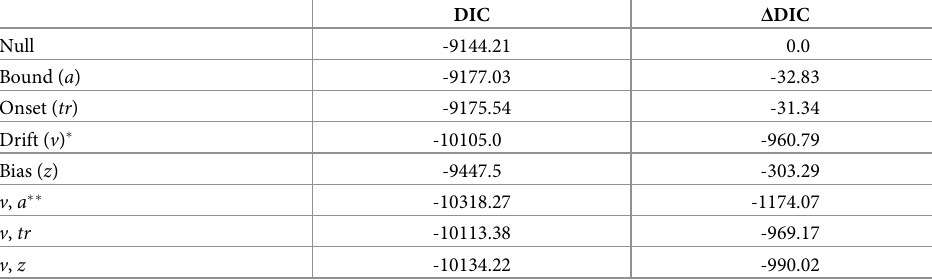
Table 1. Single- and dual-parameter DDM goodness-of-fit statistics. DIC is a complexity-penalized measure of model fit, DIC = D( θ ) + pD , where D( θ ) is the deviance of model fit under the optimized parameter set θ and pD is the effective number of parameters. Δ DIC is the difference between each model’s DIC and that of the null model for which all parameters are fixed across conditions. Asterisks denote models providing best fits within the single-parameter group ( � ) and across both groups ( ��